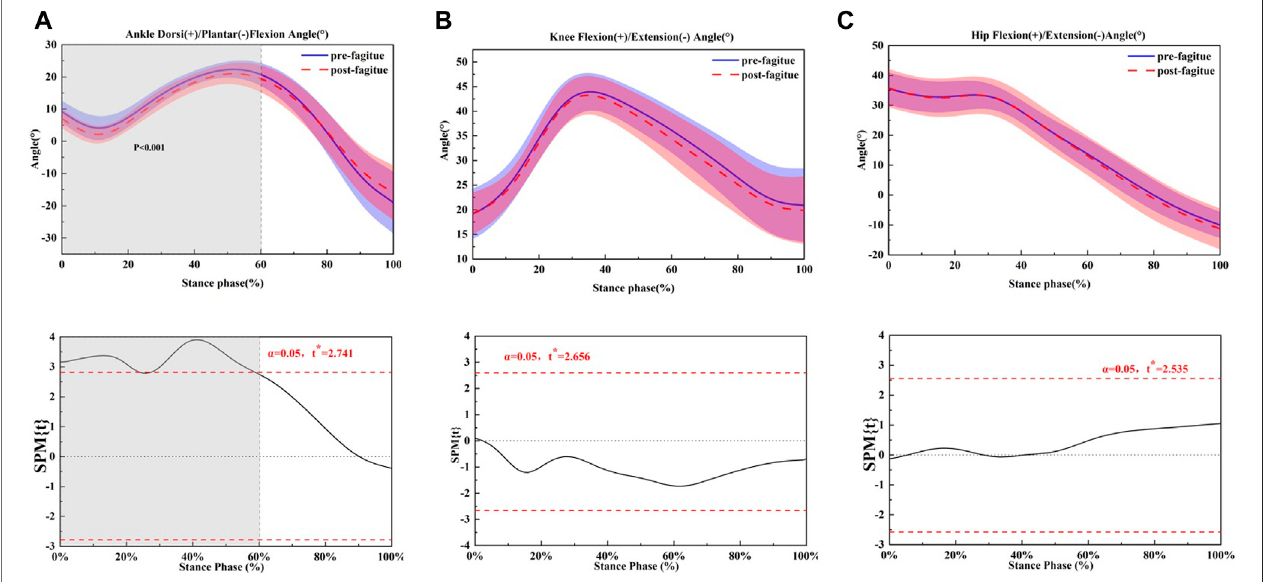
Frontiers in Bioengineering and Biotechnology |